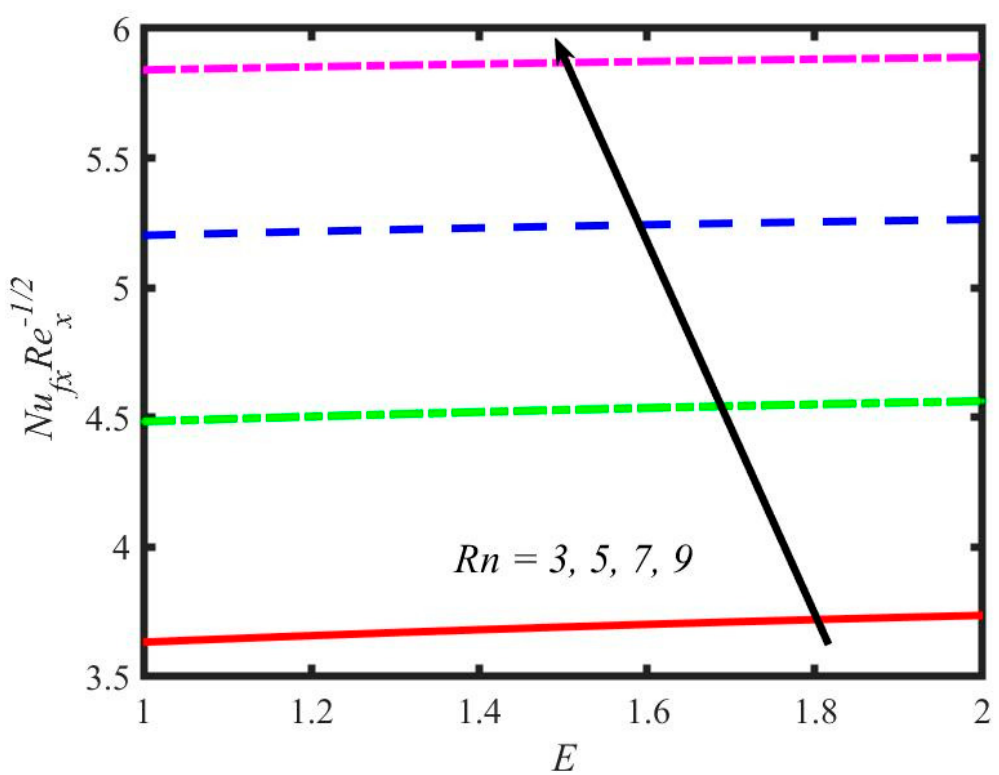
Figure 31. Variations in local Nusselt number for radiation parameter.